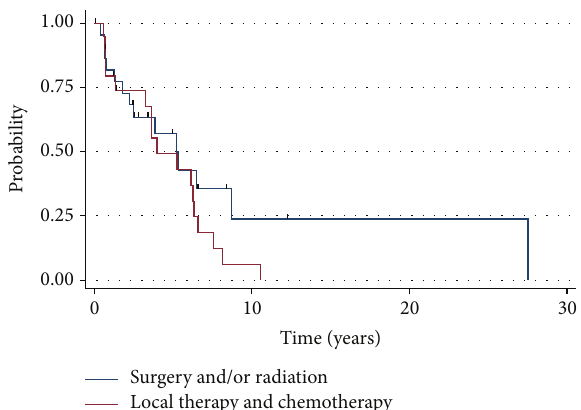
Figure 3: Progression-free survival for adults with L2 stage neuroblastoma. 𝑃 = 0.23 .